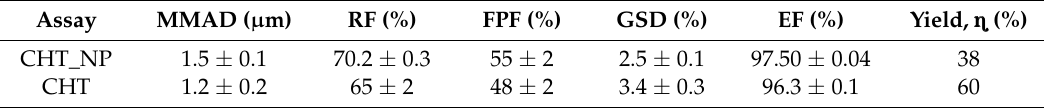
Microparticles’ aerodynamic properties. Comparison between CHT alone and